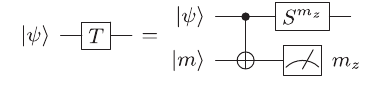
FIG. 11. State injection algorithm: A CNOT between a qubit j ψ i measurement of j m i with outcome m is equivalent to a T gate on the